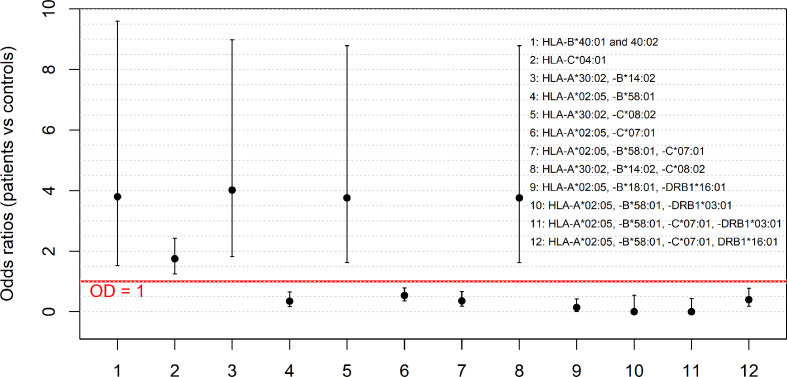
The HLA alleles and haplotypes which confer susceptibility to or protection against SARS-CoV-2 infection. The figure shows the odds ratios (OR) for the significantly different frequencies observed for HLA alleles and haplotypes (HLA-B*40:02; HLA-C*04:01; HLA-A*30:02, -B*14:02; HLA-A*02:05, -B*58:01; HLA-A*30:02, -C*08:02; HLA-A*02:05, -C*07:01; HLA-A*02:05, -B*58:01, -C*07:01; HLA-A*30:02, -B*14:02, -C*08:02; HLA-A*02:05, -B*58:01, -DRB1*03:01; HLA-A*02:05, -B*18:01, -DRB1*16:01; HLA-A*02:05, -B*58:01, -C*07:01, -DRB1*03:01 and HLA-A*02:05, -B*58:01, -C*07:01, DRB1*16:01) in the two groups of COVID-19 patients and controls. The error bars, computed according to the two-tailed Fisher’s exact test, represent the 95% confidence intervals of the OR. The red line represents the threshold OR = 1 at which the HLA allele and haplotype frequencies in the two groups of patients and controls are equal.